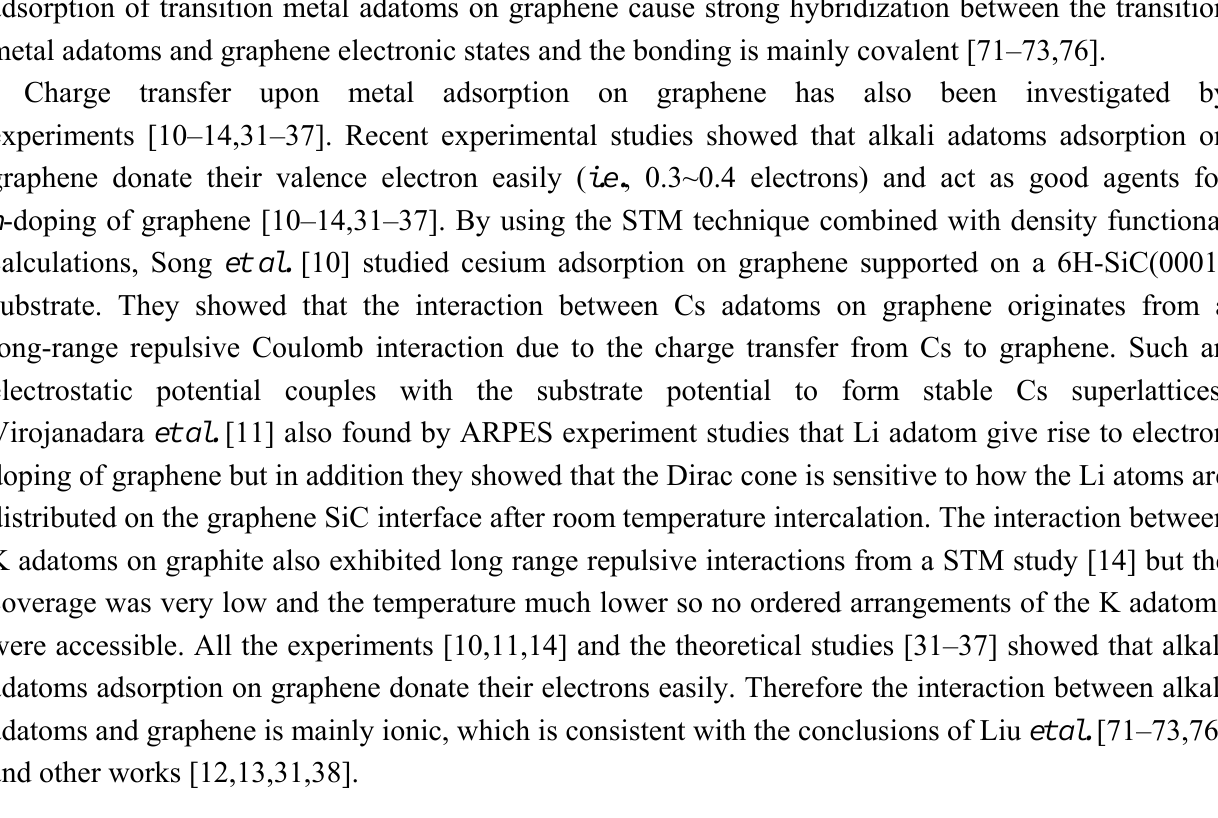
Figure 11. ( a ) Charge transfer ( Δ q) due to adatom adsorption; ( b ) Bond order of adatom/graphene